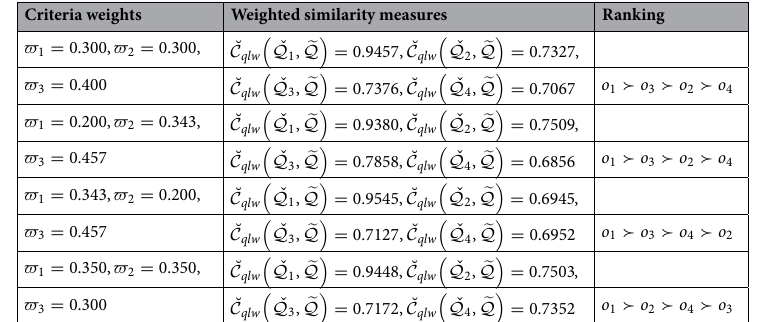
Table 10. Ranking of alternatives under different values of criteria.